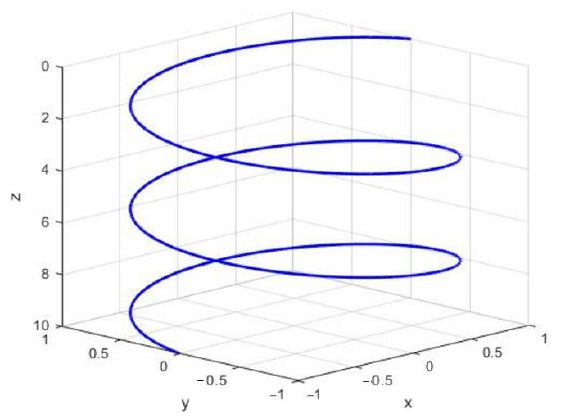
Figure 4. Parameterized desired spiral trajectory of the Unmanned Underwater Vehicle (UUV) BlueROV2.